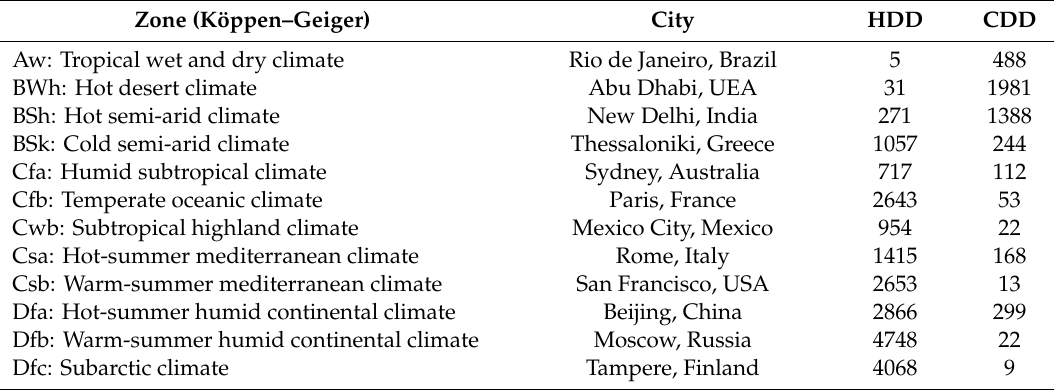
Table 1. Selected cities, corresponding climate zones, and heating degree days (HDD) and cooling degree days (CDD)